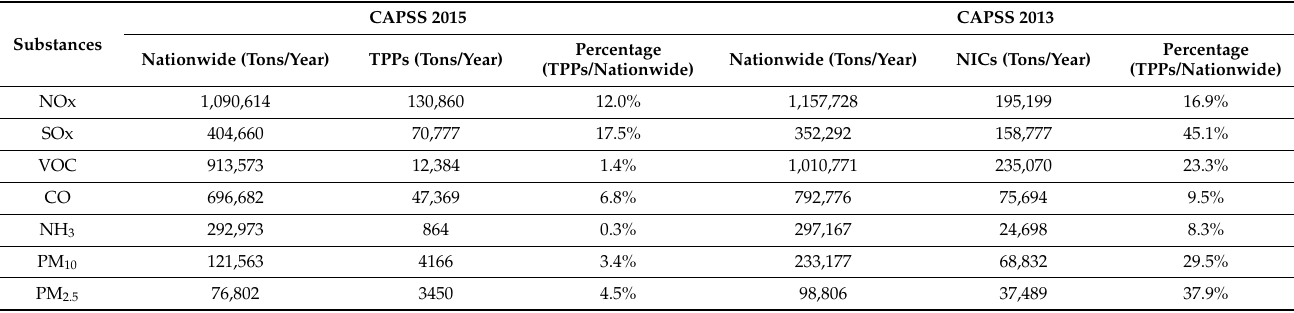
Table 3. Annual emissions of major substances by pollution source in South